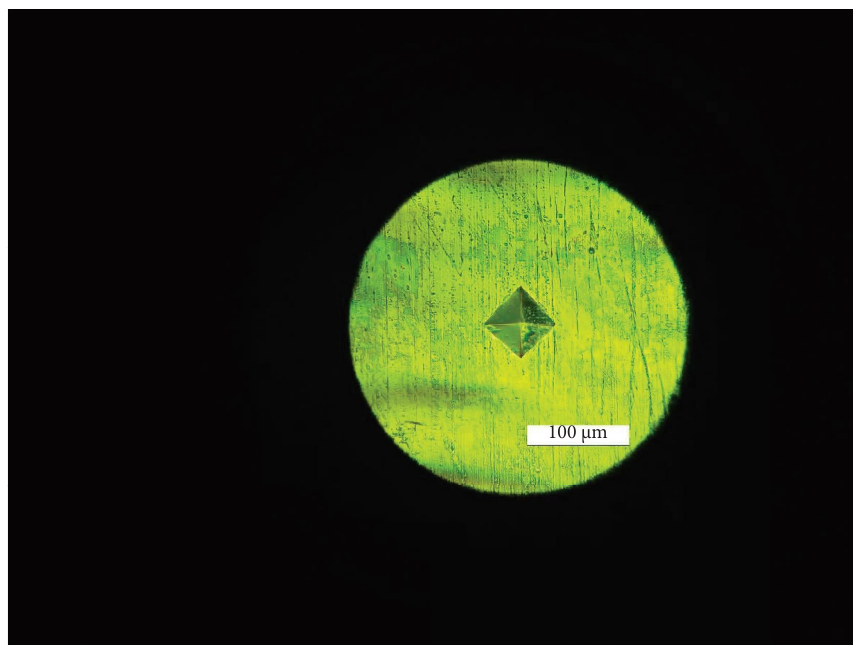
Figure 1: Indent formed with Vickers microhardness indenter.